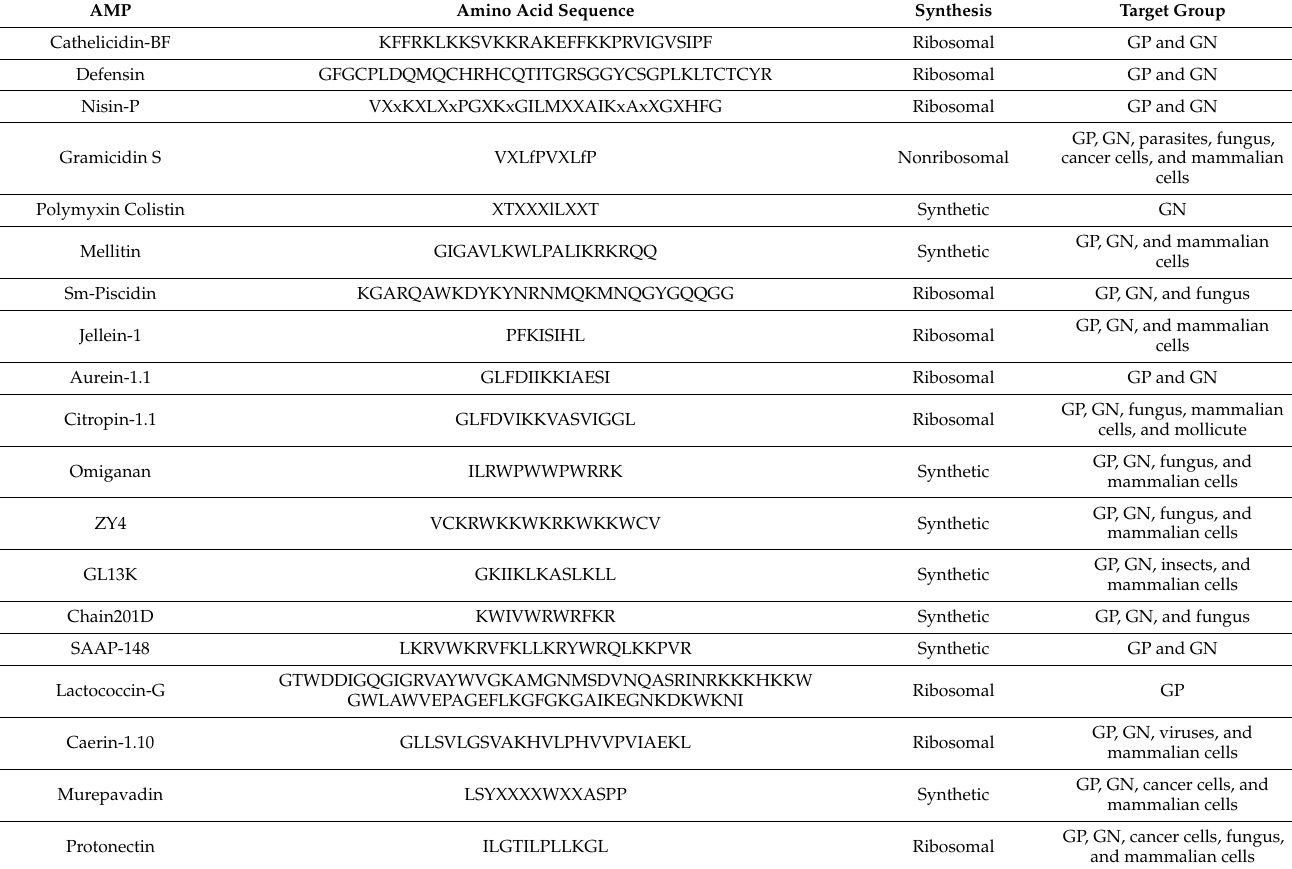
Table 2. Amino acid sequences, type of synthesis and target groups of the AMPs discussed in this paper. Data were retrieved from the database of antimicrobial activity and structure of peptides [102]. GP: Gram-positive bacteria; GN: Gram-negative